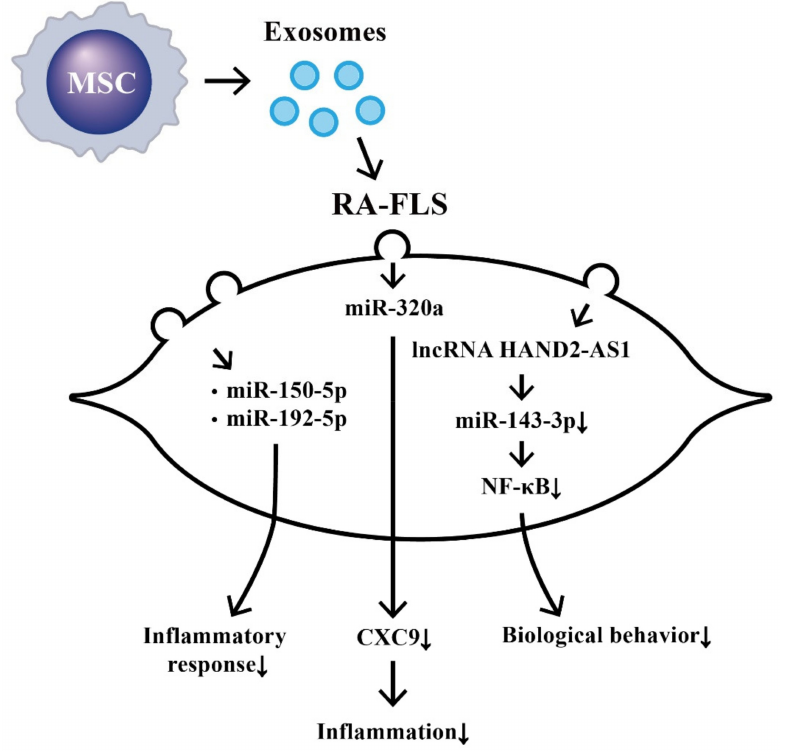
Figure 7. The effects of exosomes released from bone-marrow-derived mesenchymal stem cells (BM-MSCs) on the changes in biological behavior of rheumatoid arthritis fibroblast-like synoviocytes (RA-FLSs). The extruded exosomes containing ncRNAs are enclosed by a lipid bilayer and can move, attach, and merge into the remote RA-FLSs to influence their biological behaviors. Some of the miRs can then suppress inflammatory responses, chemotaxis, and biological behaviors of